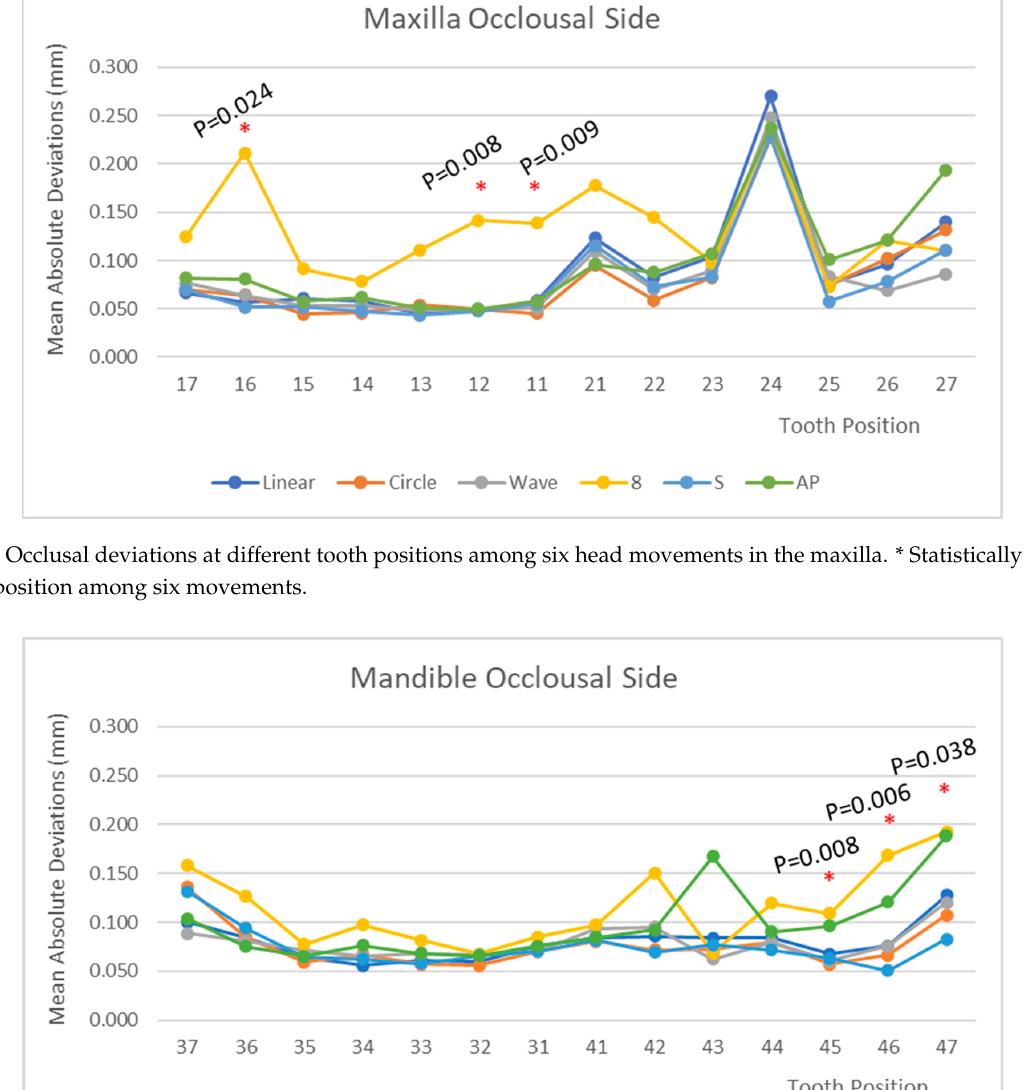
Figure 5. Occlusal deviations at different tooth positions among six head movements in the mandible. * Statistically different at tooth position among six movements.